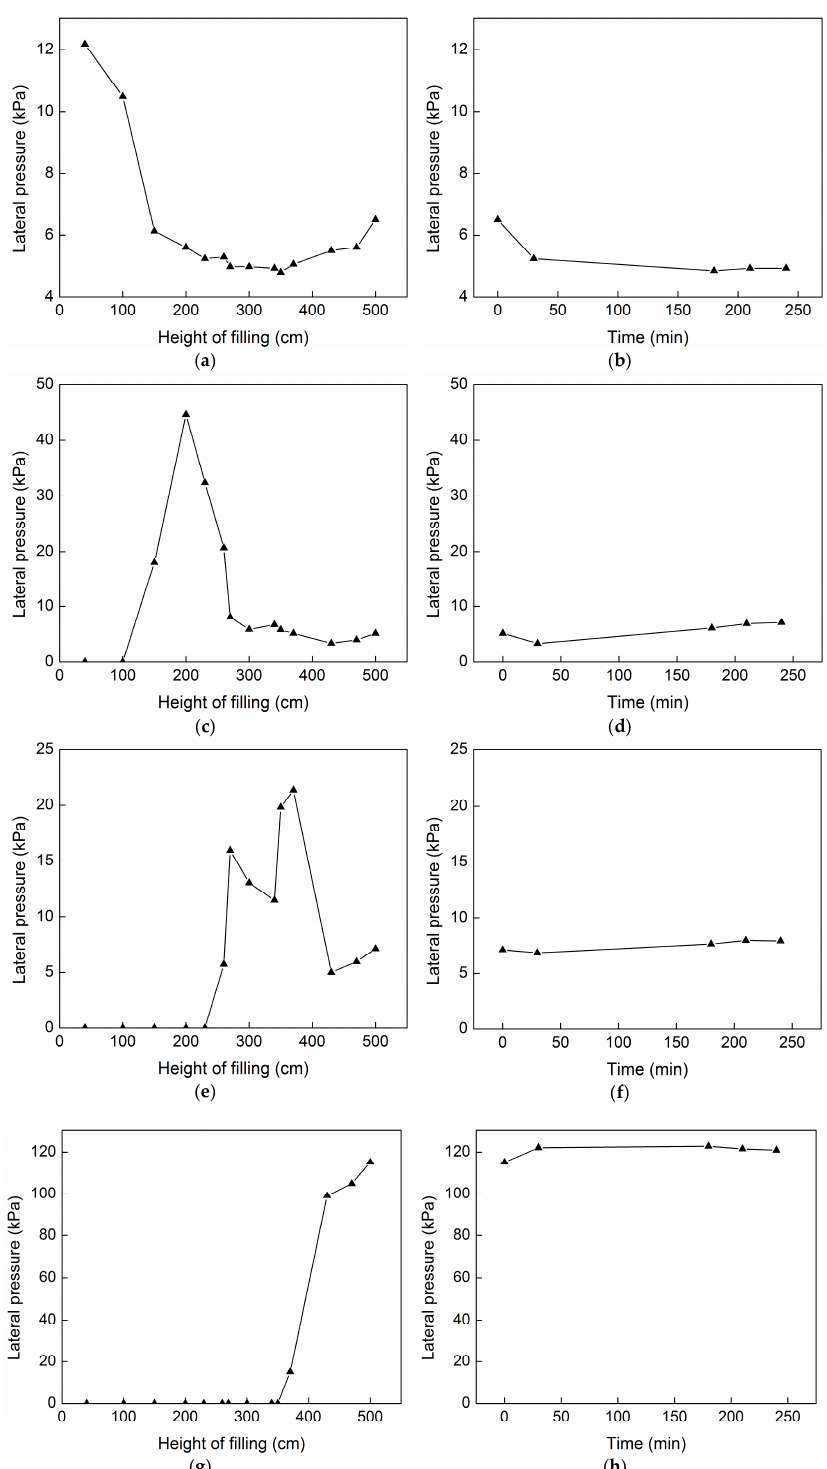
Figure 4. Pressure change diagrams of pressure boxes: ( a ) the pressure of No. 1 pressure boxes as a function of the filling height; ( b ) the pressure of No. 1 pressure boxes as a function of time after filling completion; ( c ) the pressure of No. 2 pressure boxes as a function of the filling height; ( d ) the pressure of No. 2 pressure boxes as a function of time after filling completion; ( e ) the pressure of No. 3 pressure boxes as a function of the filling height; ( f ) the pressure of No. 3 pressure boxes as a function of time after filling completion; ( g ) the pressure of No. 4 pressure boxes as a function of the filling height; and ( h ) the pressure of No. 4 pressure boxes as a function of time after filling completion.